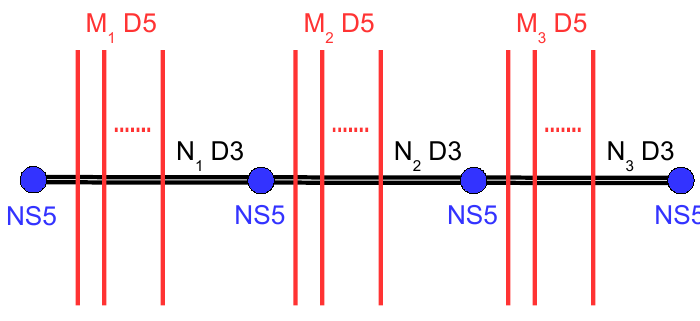
Figure 2 . Brane con(cid:12)guration associated to a general linear quiver with three